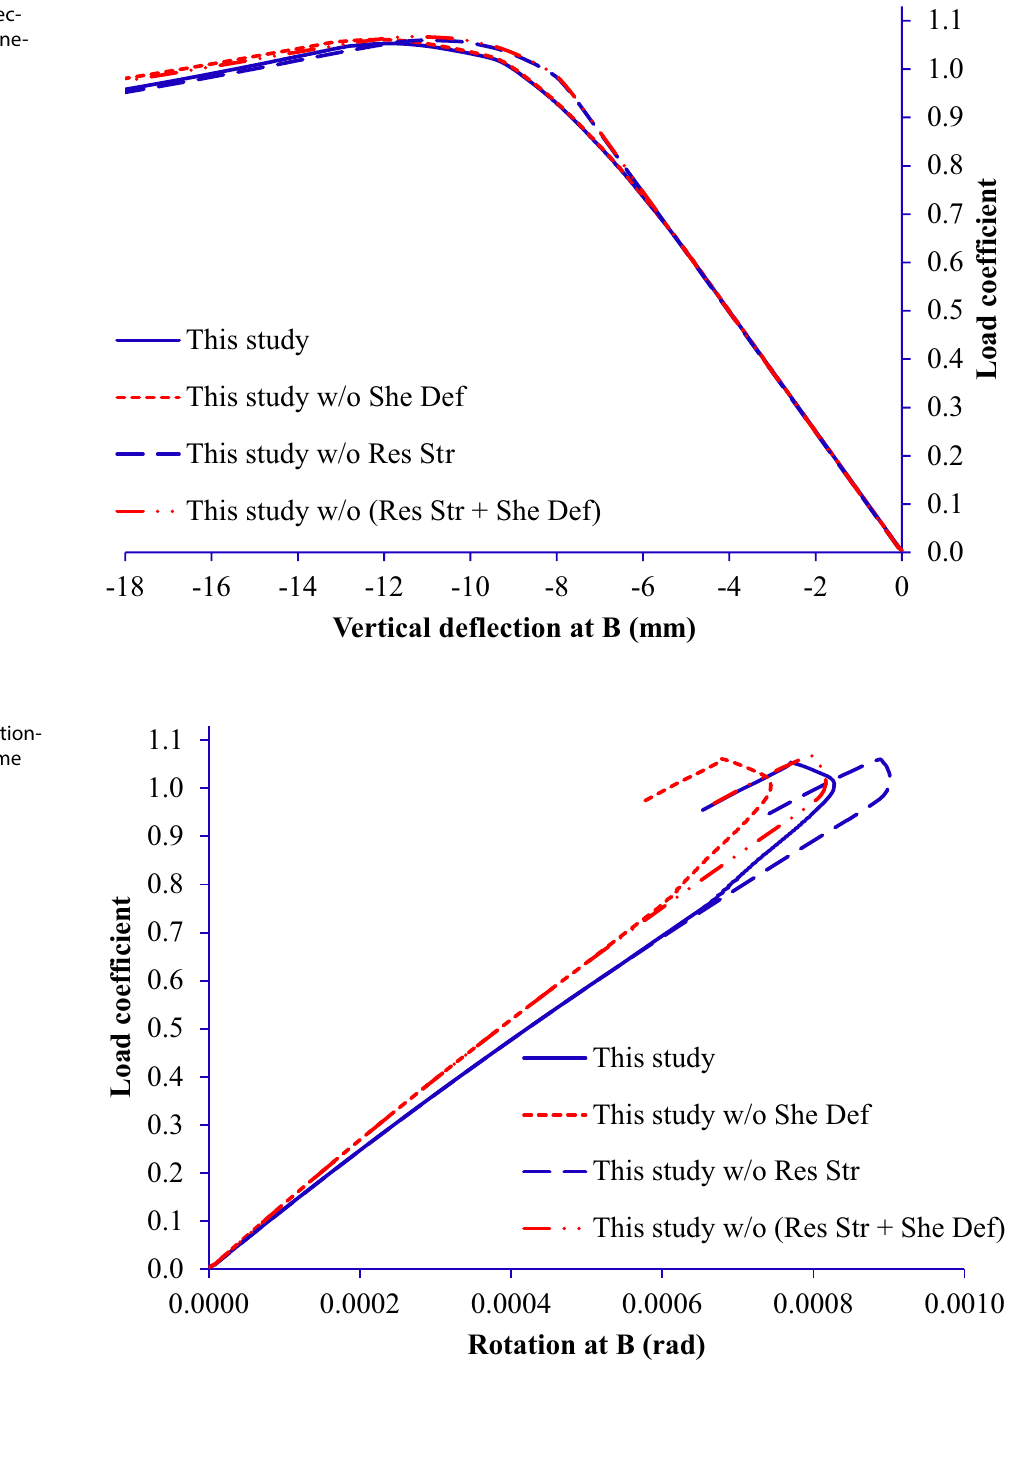
Fig. 30 Load-vertical deflec- tion relationship at B of nine- story frame